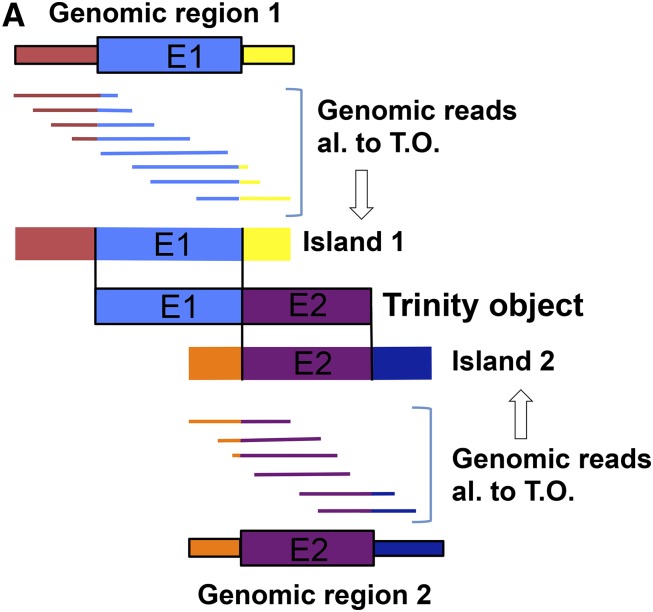
Potential for RNA splicing to assemble consensus islands of genomic sequence into mRNA: the splicing test. (A) Tiled genomic reads (specific segments indicated by different colors) aligned to a Trinity object encoded by two discontiguous segments E1 and E2 yield island consensus sequences (‘Island 1’, ‘Island 2’). Each island has a central segment identical to E1 or E2 and flanking sequences not found in the Trinity object. Note that when aligned within the Trinity ‘frame’, Islands 1 and 2 have no sequence in common, even though each aligns to a large segment of the Trinity object. (B) Consensus sequences for splicing in Chlamydomonas. Splice sites from the annotated Phytozome reference genome were collected and analyzed using the Weblogo algorithm (Crooks et al. 2004; http://weblogo.berkeley.edu). The human consensus is shown for comparison. (C) The splicing test. Consensus islands assembled as in (B) can be assembled into mRNA only by a join at a highly restricted location [in the absence of any terminal direct repeats, a single nucleotide at the terminus (start or finish) of each island]. This provides a highly constrained condition for searching for splice site homology (donor and acceptor positions; the most likely start and finish positions are indicated by green or red arrows). A series of consensus islands connected by high-confidence splices on the same strand forms a ‘connected island’; a candidate hidden exon should be contained within such a connected island to pass the splicing test.